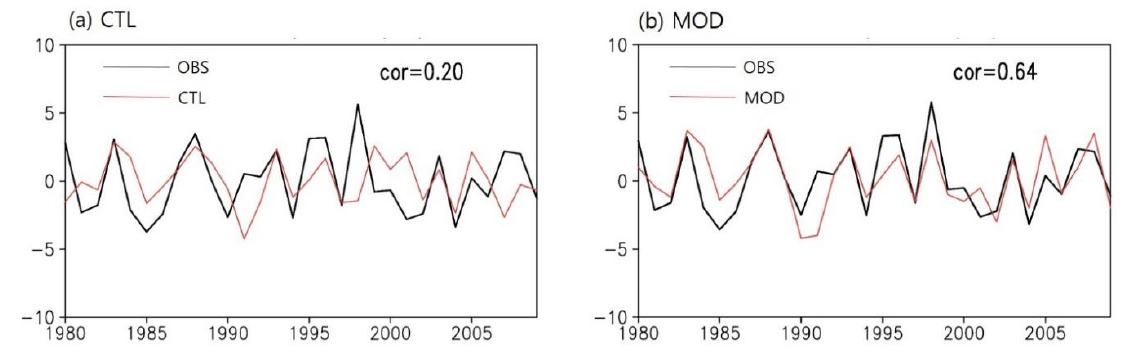
Figure 13. Year-to-year variations of the Wang and Fan index (m s − 1 ) from: ( a ) CTL; and ( b ) MOD. The WF index is defined by zonal wind at 850 hPa over (22.5 – 32.5° N, 110 – 140° E) minus (5 – 15° N, 90 – 130° E). The black line represents observed WF.